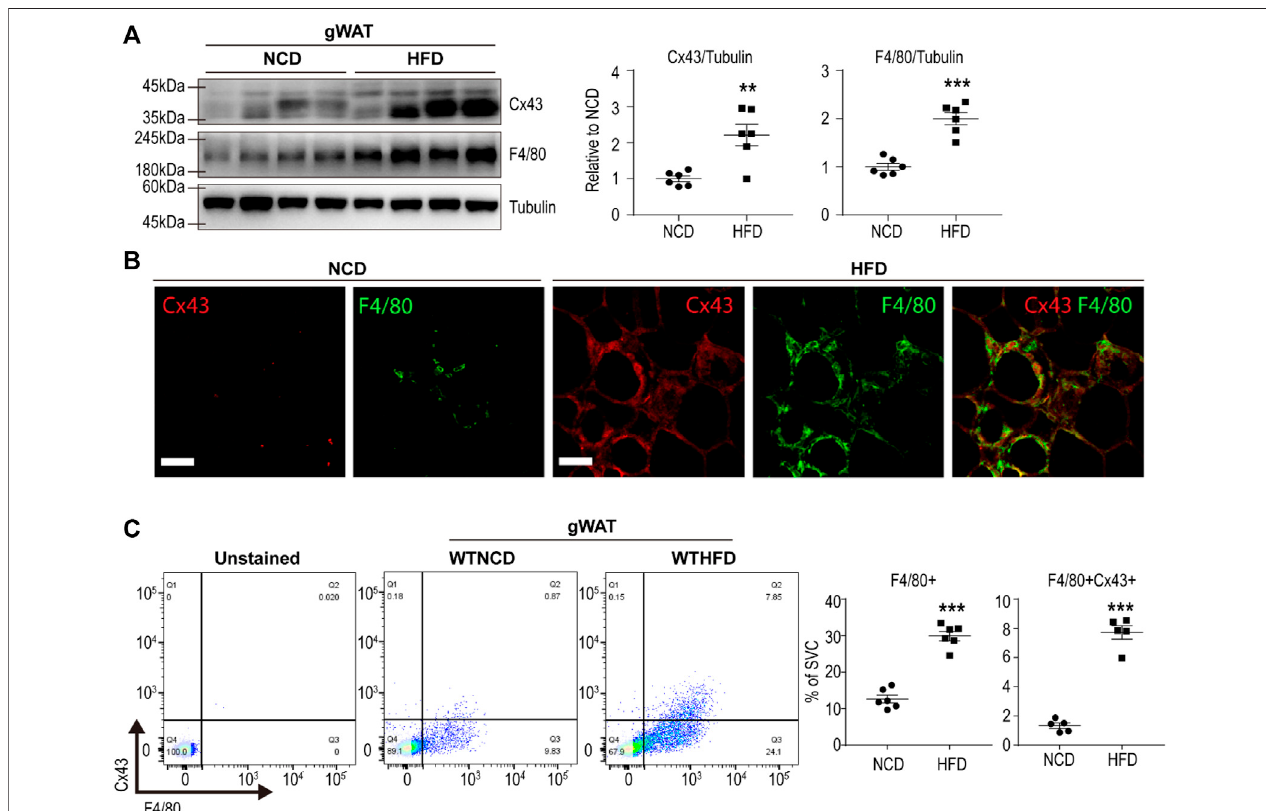
FIGURE 1 | Cx43 is upregulated in gonadal white adipose tissue macrophages of mice by high-fat diet feeding (A) Immunoblot analysis of Cx43 and F4/80 expression in gonadal white adipose tissue (gWAT) of mice fed normal chow diet (NCD) or high-fat diet (HFD) for 8 weeks ( n = 6) (B) Immuno- fl uorescence images of paraf fi n sections of gWAT of mice fed NCD or HFD, stained for Cx43 and F4/80 (C) Flow cytometric analysis of stromovascular cells (SVCs) obtained from gWAT of WT micefedwithNCD or HFD for8 weeks (n=6). Unpaired, two-tailed t-tests (** p < 0.01, *** p < 0.001), each point representsbiological replicate. Dataarepresented as mean ±